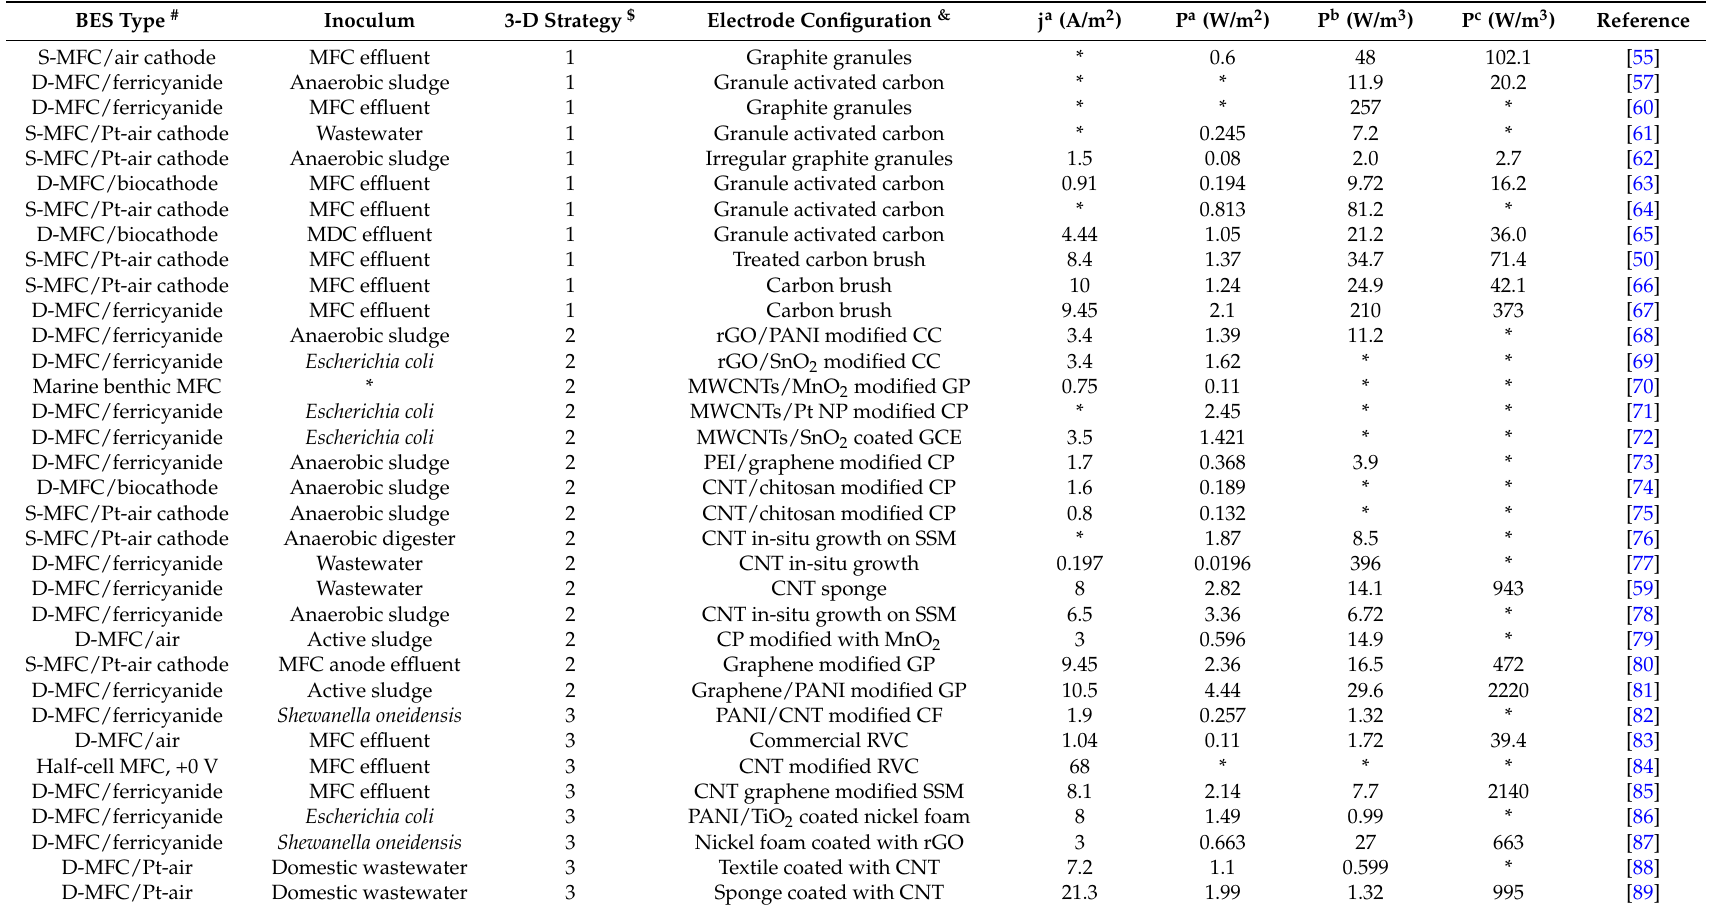
Table 1. Representative 3D electrodes in